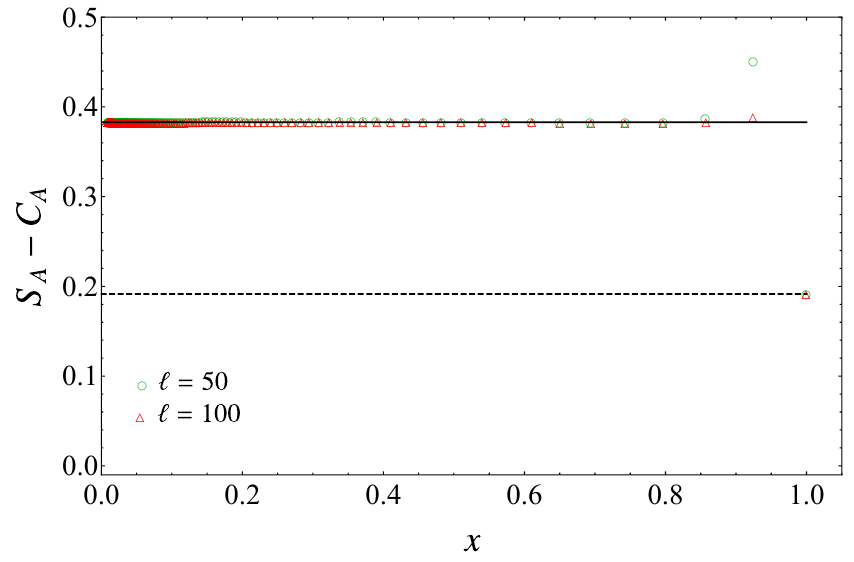
Figure 1 . S A − C A in terms of the cross ratio x for two equal disjoint intervals of length ‘ in a free fermionic chain, where F n ( x ) = 1 identically. The horizontal solid line is obtained from (2.10) and by using the values reported in the text for the non-universal constant terms. The height of the dashed line is half the height of the solid